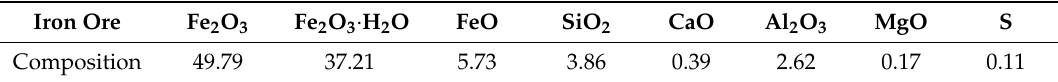
Table 2. Composition of iron ore (mass,